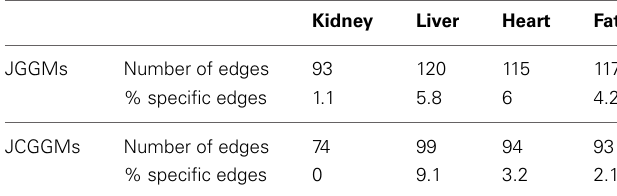
Table 3 | Results from JGGM and